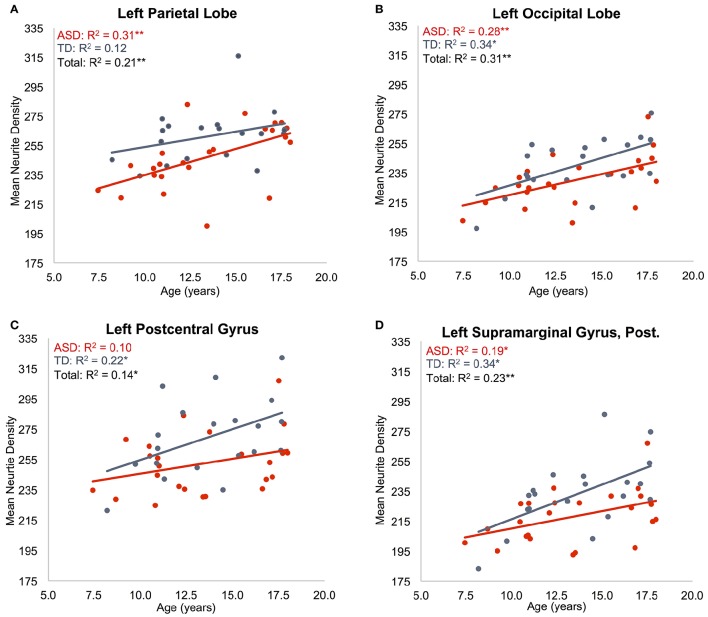
Effects of age on neurite density. Mean ND is shown as a function of subject age for: (A) left parietal lobe, (B) left occipital lobe, (C) left postcentral gyrus, (D) posterior division of left supramarginal gyrus. ASD indicated in red, TD indicated in blue. Neurite density standardized to a 0–1000 range. *p < 0.05, **p < 0.005.